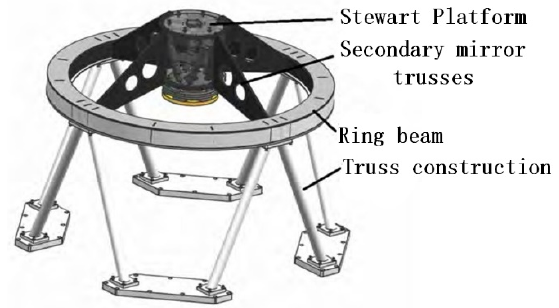
Figure 3. Secondary mirror support structure.